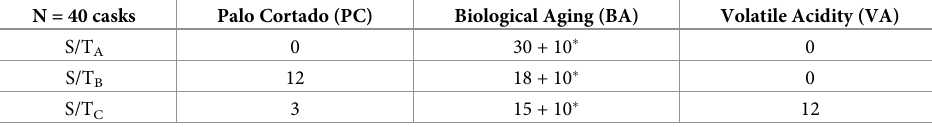
Table 1. Sensory classification results of the "sobretablas" (S/T) made by the winery after 1 year of biological aging. N = 40 casks Palo Cortado (PC) Biological Aging (BA) Volatile Acidity (VA) S/T A 0 30 + 10 � 0 S/T B 12 18 + 10 � 0 S/T C 3 15 + 10 � 12 N = 40 casks for each type of "sobretablas". Categories of classification: Palo Cortado (PC), Biological Aging (BA) and Volatile Acidity (VA). � Casks treated with lysozymes 12.5 g/hL https://doi.org/10.1371/journal.pone.0208330.t001 shows the results of the sensory classification of the 40 casks of S/T by the winery. All tasted A samples were classified as biological aging sensory profile (BA). Any of the S/T studied, A including the 10 casks that were treated with lysozyme, showed sensory deviation “palo cor- tado” (PC) or perception of volatile acidity (VA). As shown in Table 2, the wine sets S/T (BA) and S/T lys (BA) show the characteristic evo- A A lution of biologically aged wines, with respect to the control wine at t = 0 (S/T t = 0). During A this process, “flor” velum yeast consumes ethanol, glycerine and acetic acid (volatile acidity), and produce acetaldehyde, acetoin and 2,3-butanediol [10, 36, 11]. Likewise, it can be observed that there is a low reduction of malic acid in the S/T (BA) set, which could be attributed to a A certain consumption by the small population of LAB that was detected (570 CFU/mL) (Table 2). It is very common that during the biological aging in the presence of “flor” velum, a certain population of LAB coexists [21, 20] due to the semi-anaerobic conditions that are established by the aerobic metabolism of “flor” velum yeast. Anyway, the development of lactic Table 2. Evolution of analytical composition of the sets of "sobretablas" casks S/T A classified as BA after 1 year of aging. S/T A t = 0 S/T A (BA)